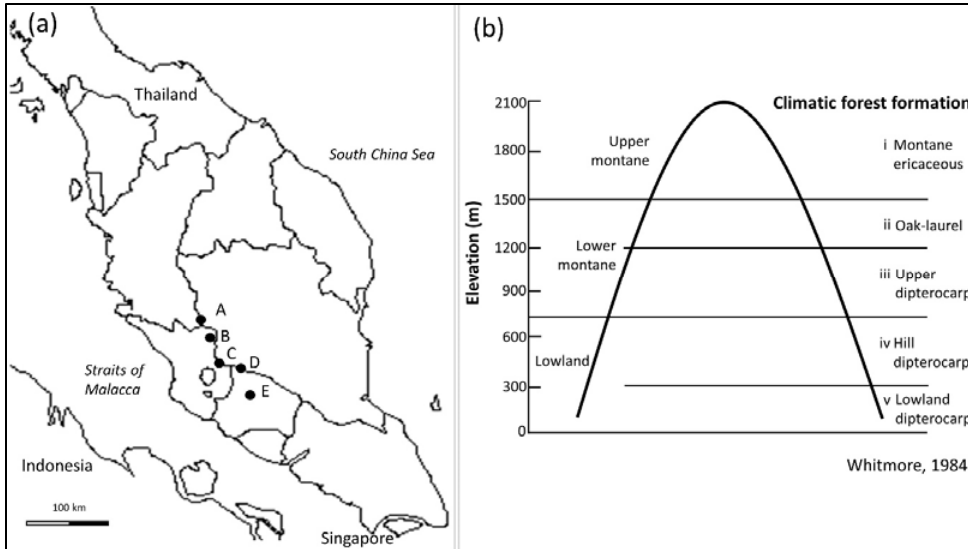
Figure 1. ( a ) Map of Peninsular Malaysia showing locations of the five mountains sampled on Banjaran Titiwangsa mountain range: (A) Gunung Liang, Perak; (B) Bukit Kutu, Selangor; (C) Gunung Nuang, Selangor; (D) Gunung Besar Hantu, Negeri Sembilan; and (E) Gunung Berembun, Negeri Sembilan. ( b ) The five climatic forest formations spanning elevations of Malaysian mountains, adapted from Whitmore [35].